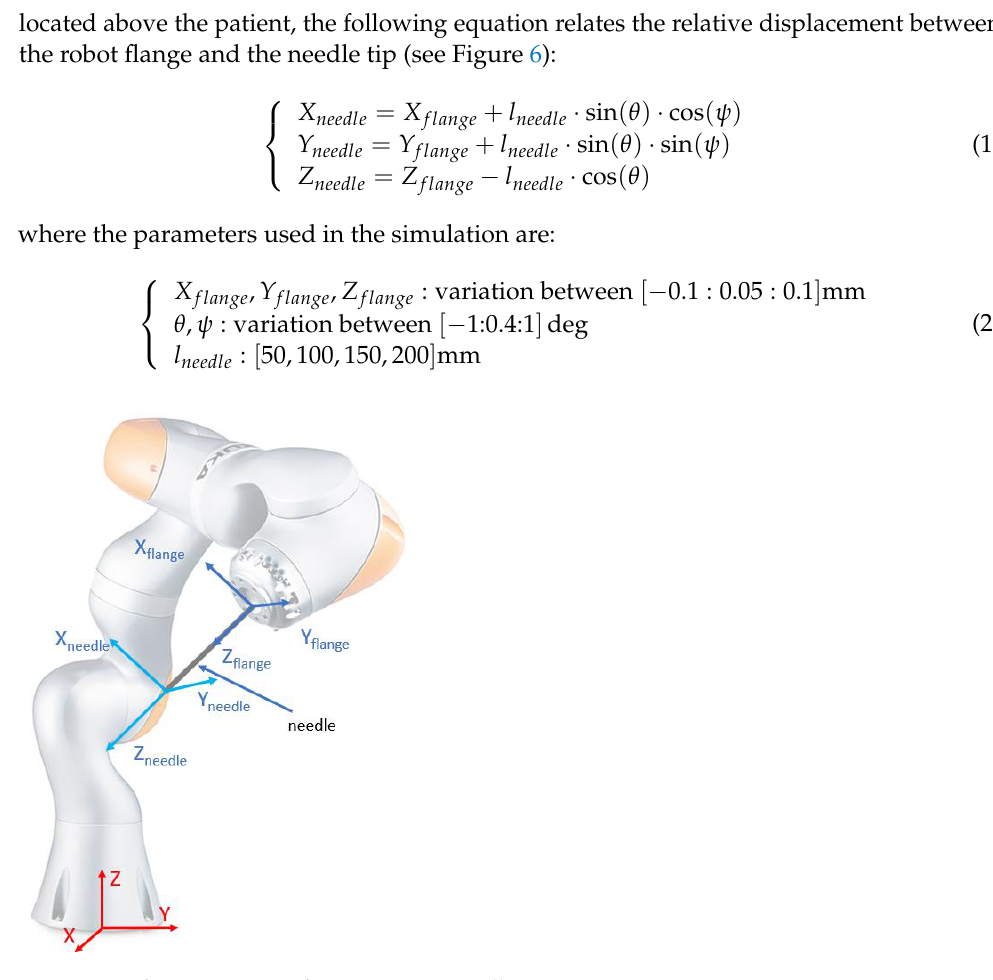
Figure 6. Reference systems for computing needle accuracy. The error propagation was studied at four different insertion depths of 50, 100, 150 and 200 mm. Figure 7 illustrates the dispersion of the robot flange locations and the needle tip location for the four different depths. Two spheres were introduced to show the ac- ceptable volume for the needle tip with respect to the ideal coordinates (with a radius of 2 mm—the maximum acceptable positioning error defined by medical data) and the non- acceptable volume (with a radius of 5 mm) to emphasize the actual dispersion of the needle coordinates location. Figures 7 and 8 illustrate the fact that for a very small dispersion error at the level of the flange, the error for the needle tip exceeds the maximum allowable errors with the increase in the tumor depth. In particular, a random number generator is used to replicate the actual coordinates at the robot flange, adding an inaccuracy to the “theoretical” coordinates. This is represented by the point cloud illustrated in Figure 7, where the red dots represent the real possible locations of the robot flange with respect to a single “theoretical” set of coordinates. The real needle tip location is determined with respect to the point cloud created earlier when the insertion is completed at various depths (50, 100, 150 and 200 mm). While the dispersion of the real flange locations is enclosed in a rectangle with sides of 0.2 mm, the resulting error at the needle tip (illustrated graphically in Figure 6) is growing exponentially, reaching up to 5 mm at the depth of 200